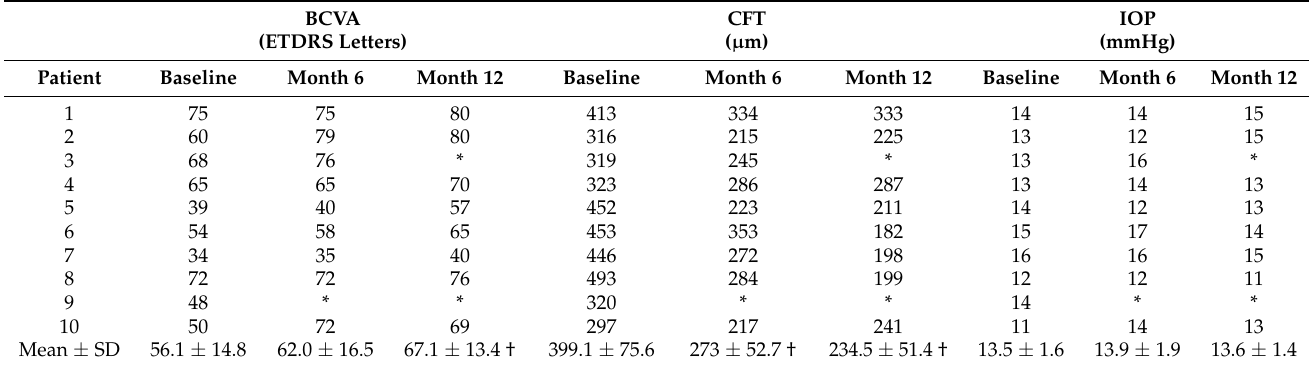
Table 2. Clinical outcomes after TALF administration as an adjuvant to anti-VEGF therapy in nAMD.